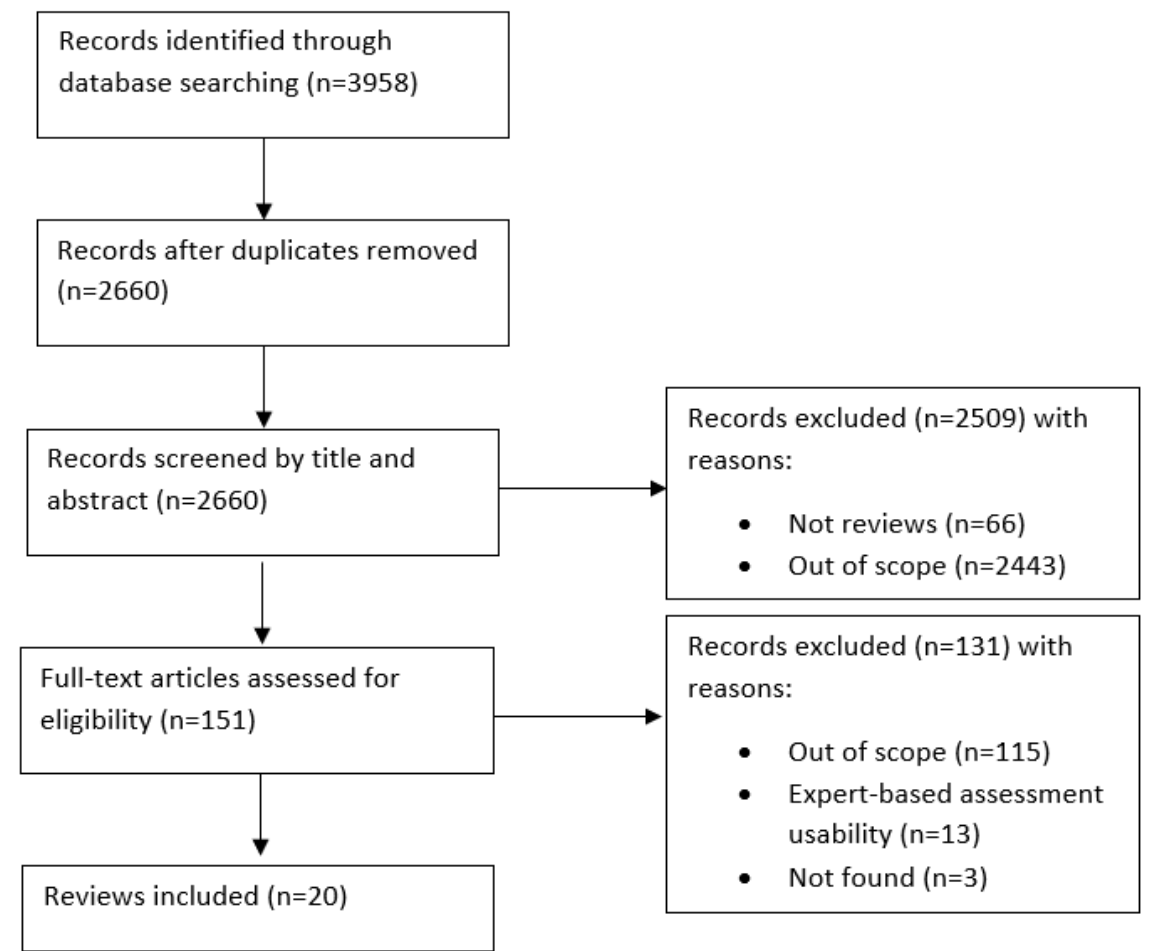
Figure 1. Flow diagram showing study identification and selection for the present